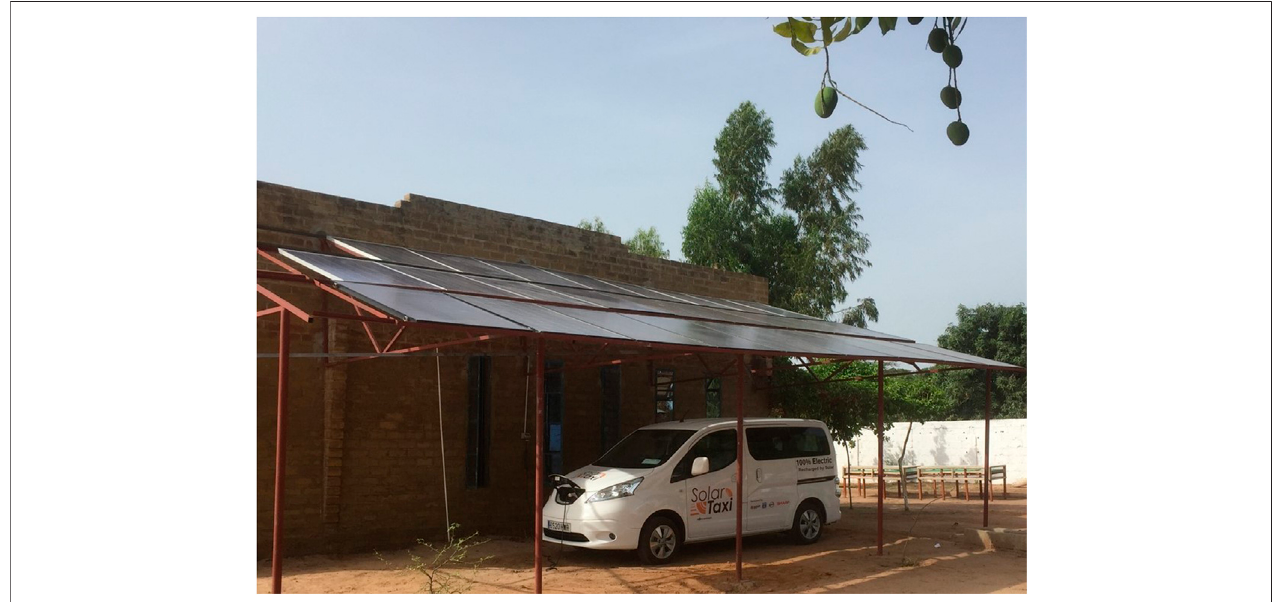
FIGURE 4 | The Solar Taxi recharging from the minigrid at Manduar that is powered by a 4.5 kW PV array that forms part of the roof of its car port (Source: Gammon, 2019).